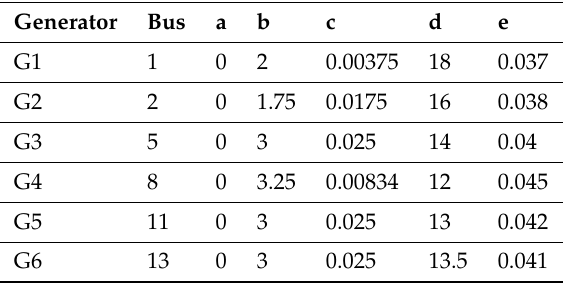
Table 2. Cost coefficients of the thermal power